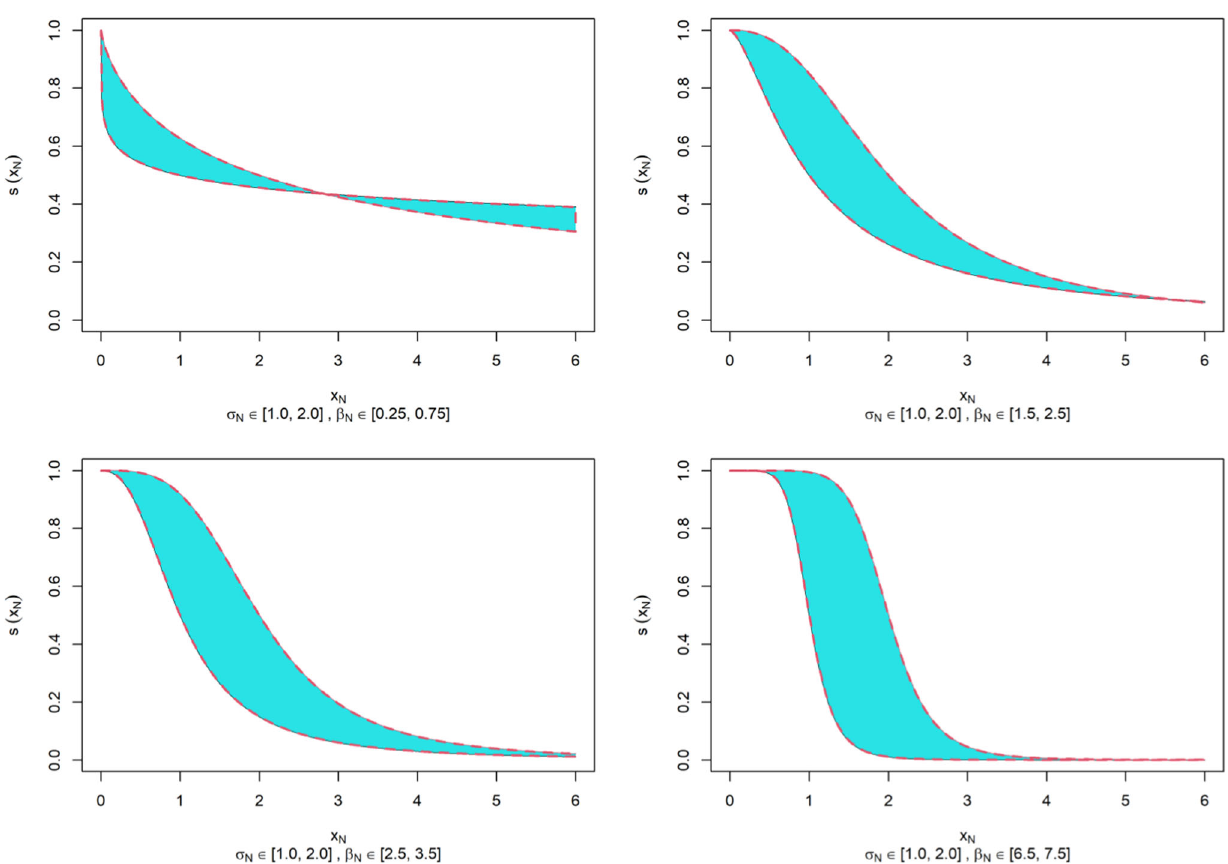
Fig. 3 The survival function curves of NLLD for various neutrosophic